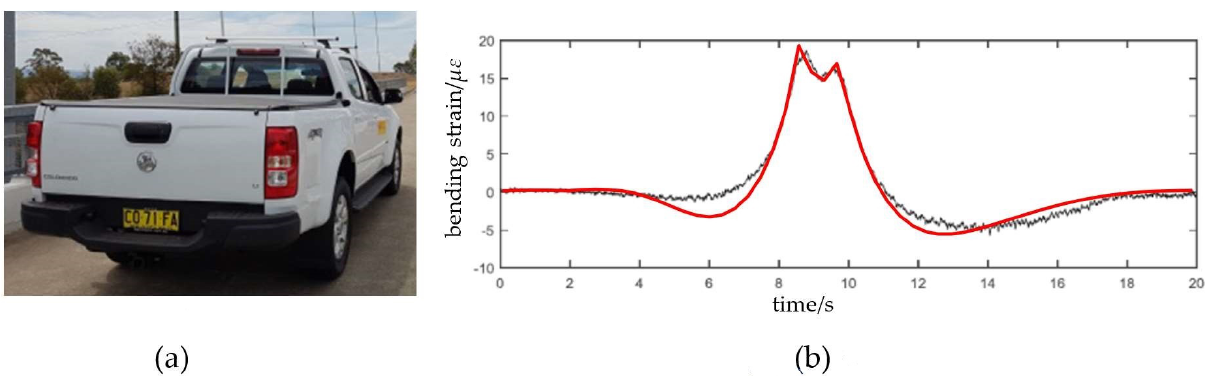
Figure 9. The test vehicle and the bending strains. ( a ) Holden Colorado Ute [1]; ( b ) the measured bending strain (black line) [1] and the FEM bending strain (red line) [18].